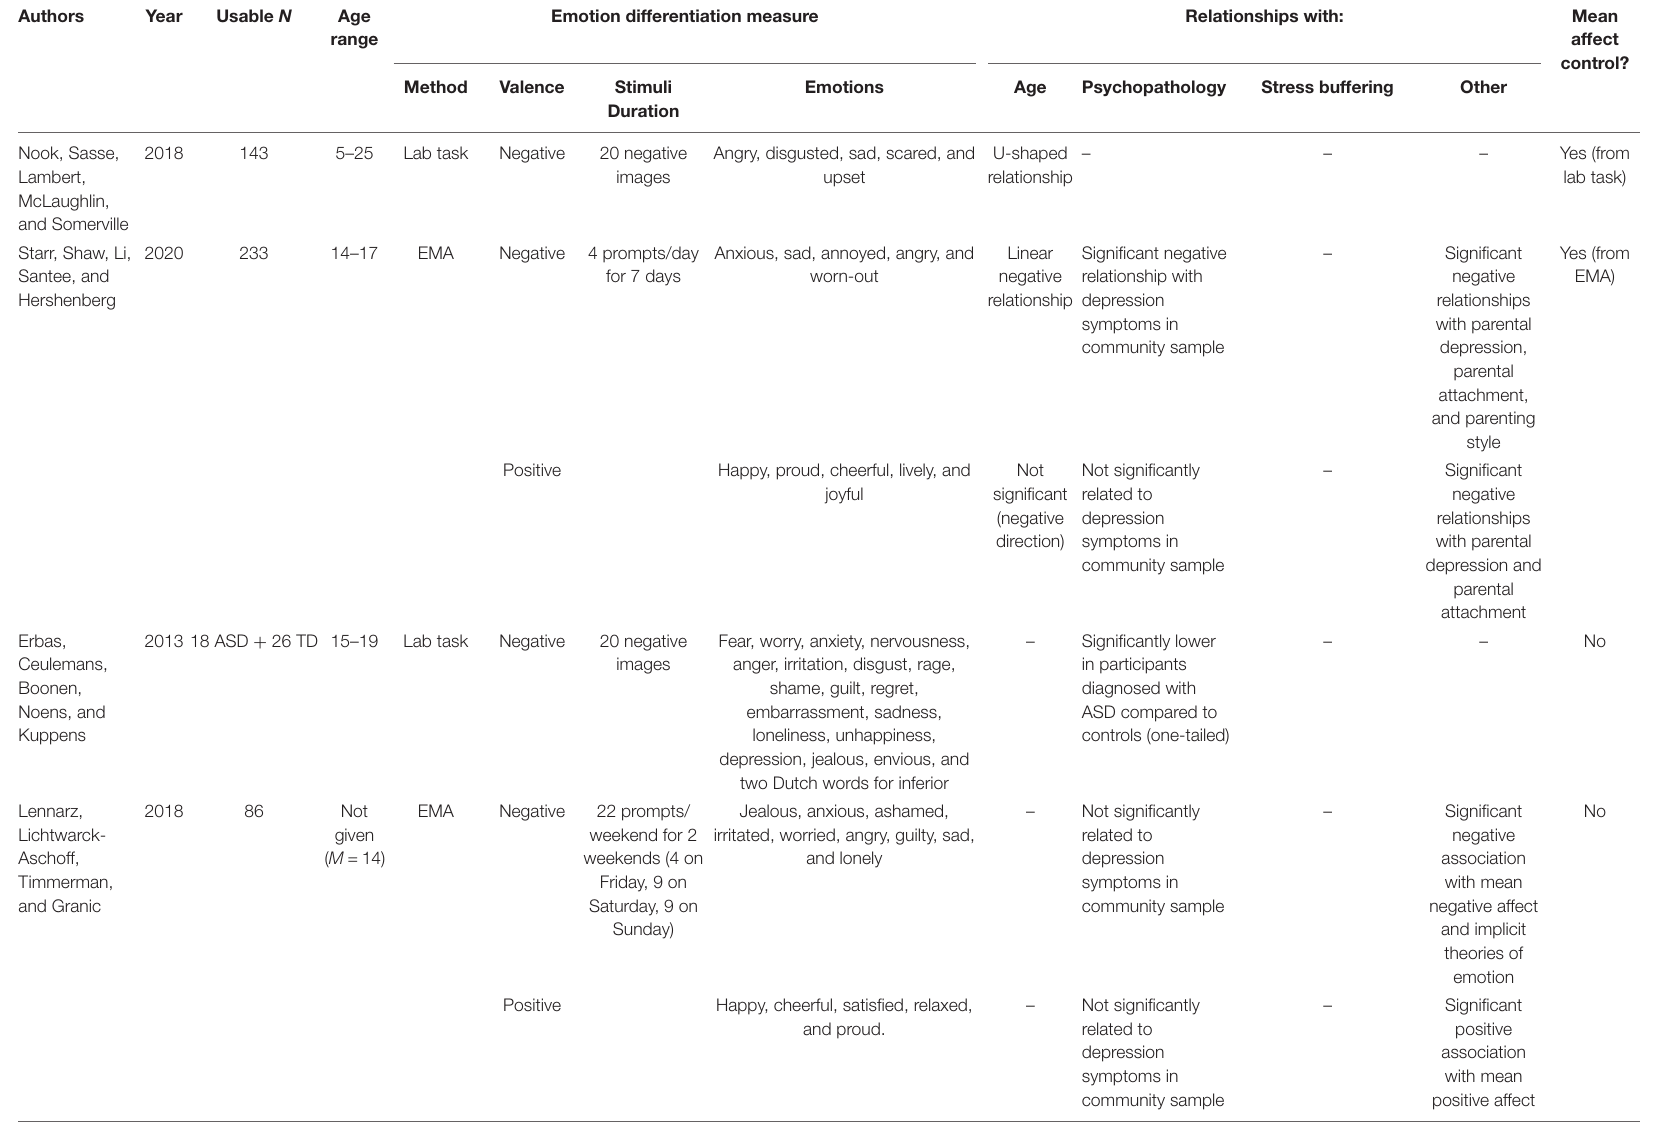
TABLE 1 | Published papers investigating emotion differentiation in